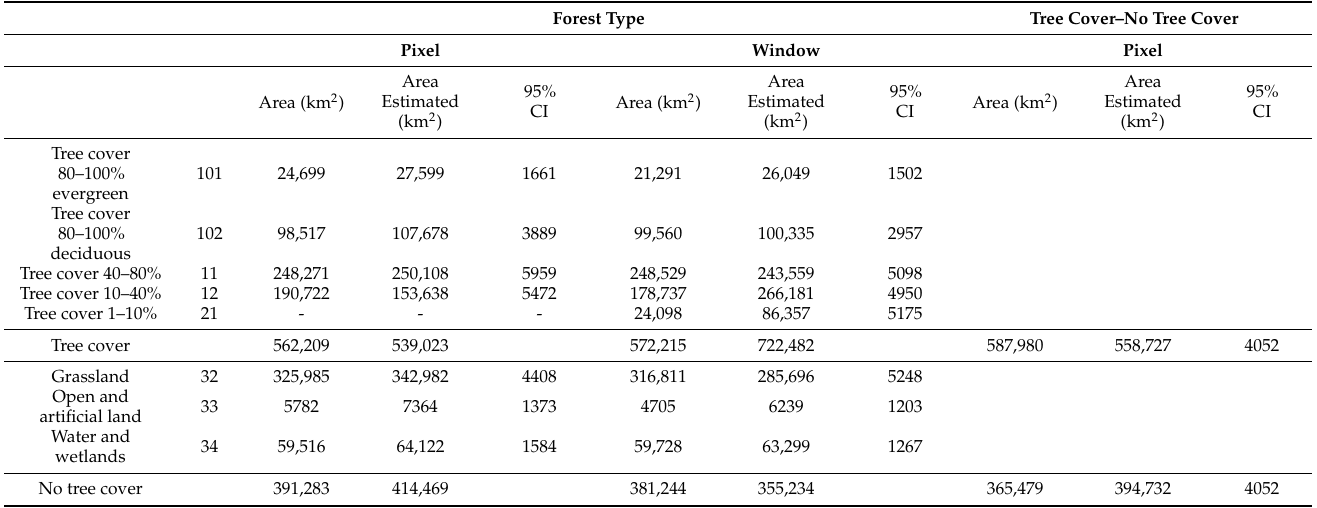
Table 3. Area estimation of the tree cover and forest types in Tanzania in the year 2018 for three different classification